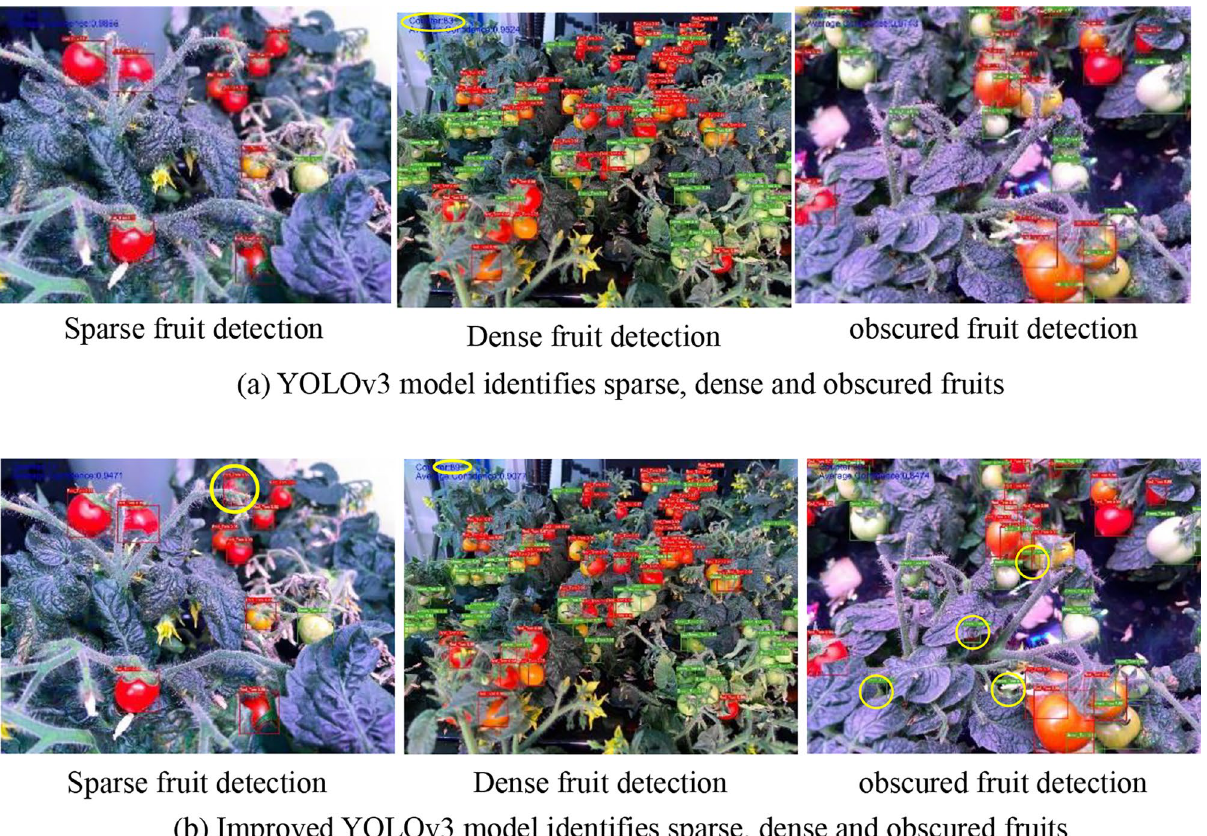
Figure 10. Fruit recognition effect in special field of